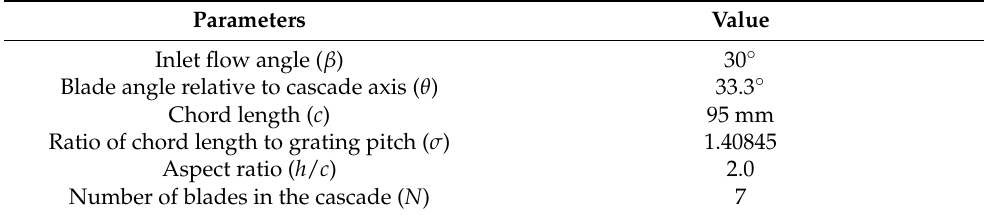
Table 2. Design parameters of transonic VKI-RG